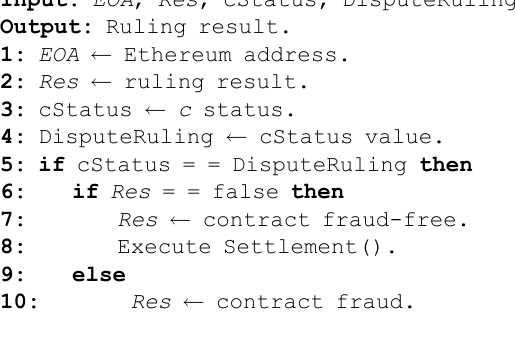
Algorithm 3 Contract fraud dispute